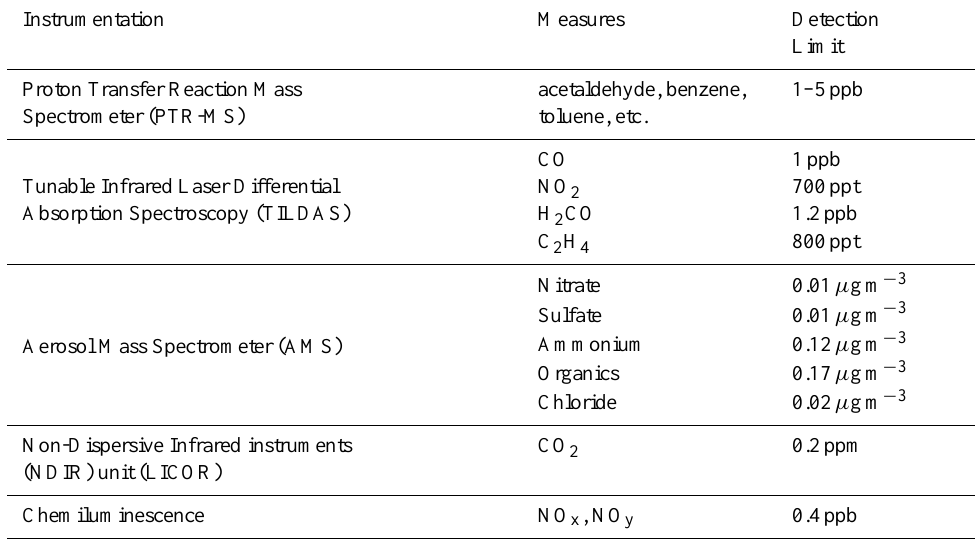
Table 1. Instrumentation on board the Aerodyne mobile laboratory used for on-road emission measurements during the MCMA-2006 field campaign a .